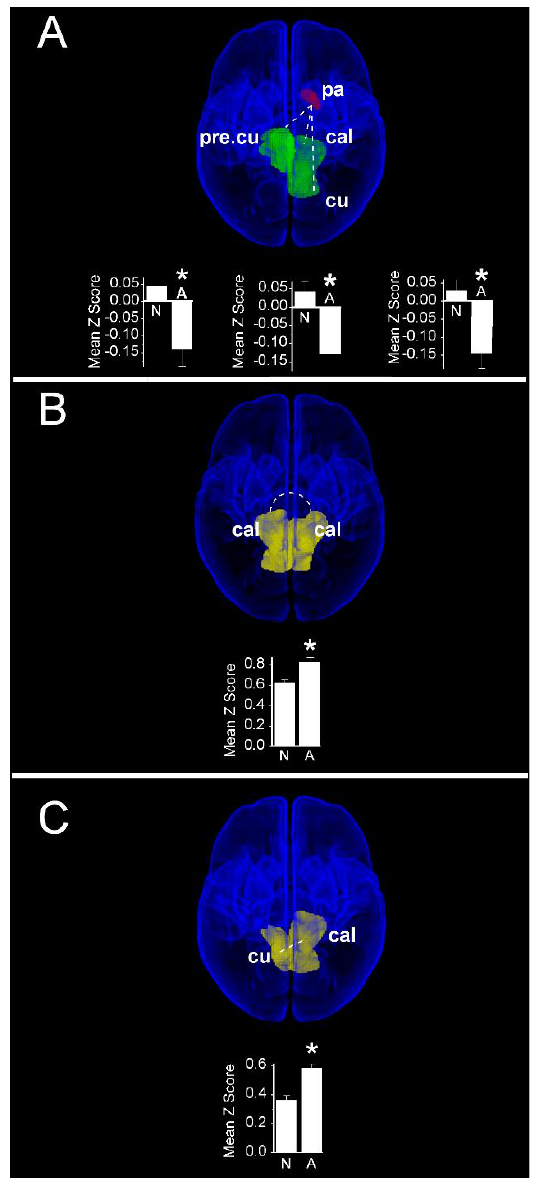
Figure 8. Region pairs exhibiting increased and decreased functional connectivities in infants with normal ( ≥ 85) and abnormal ( < 85) scores on the motor subscale of the Bayley III assessment at two years post-menstrual age. Obliquely projected 3D reconstructions of MRI images of cerebral grey matter and identified parcellated regions derived from a neonatal atlas. Dashed white lines depict connectivity relationships. Inset: Fisher-transformed Z-scores ± 1 SEM. ( A ) Increased connectivity between pallidum and visual cortex regions: left: left pallidum and contralateral precuneus; middle: Left pallidum and ipsilateral calcarine cortex; and right: Left pallidum and ipsilateral cuneus. ( B ) Decreased connectivity between bilateral calcarine cortices; ( C ) Decreased connectivity between left calcarine and right cuneus. N: Normal; A: Abnormal. * P FDR <